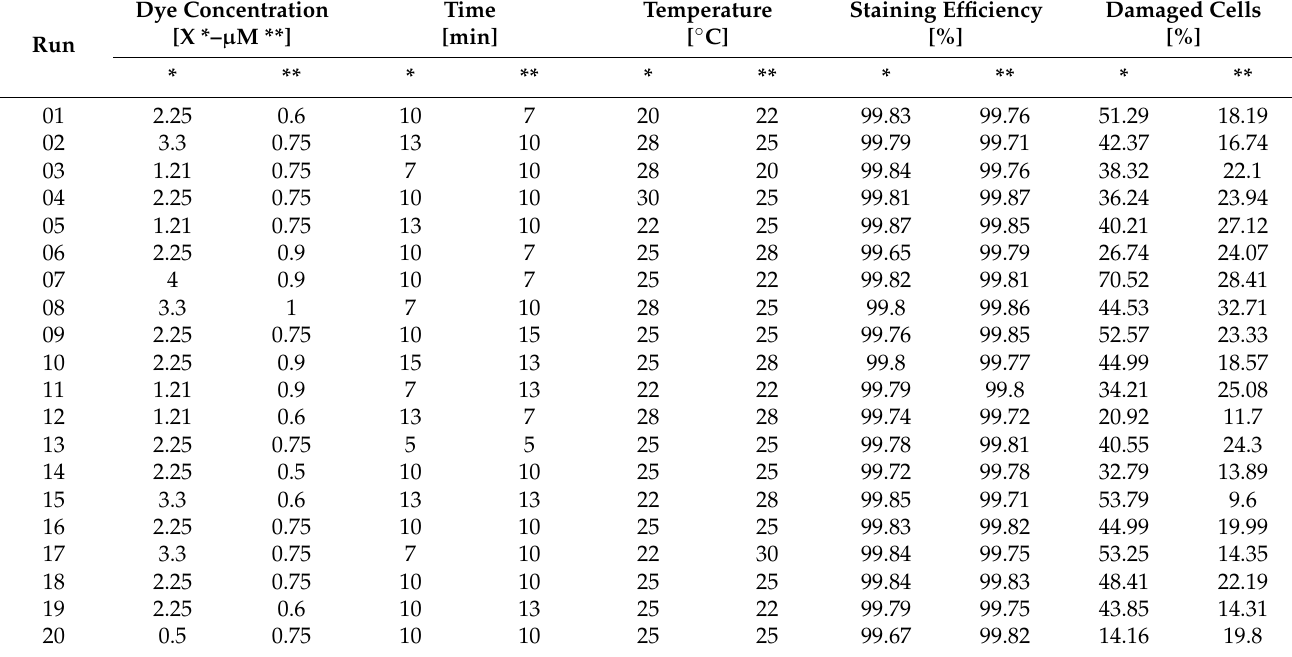
Table 2. Central composite design and results for the staining efficiency and damaging effect of both dyes studied.